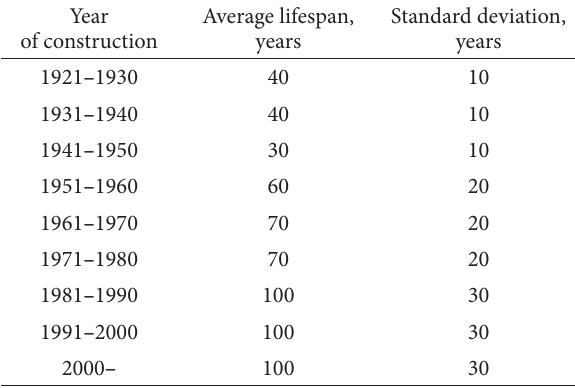
Table 1. Estimated results for bridge lifespans by decade of construction in Japan (Tamakoshi et al.